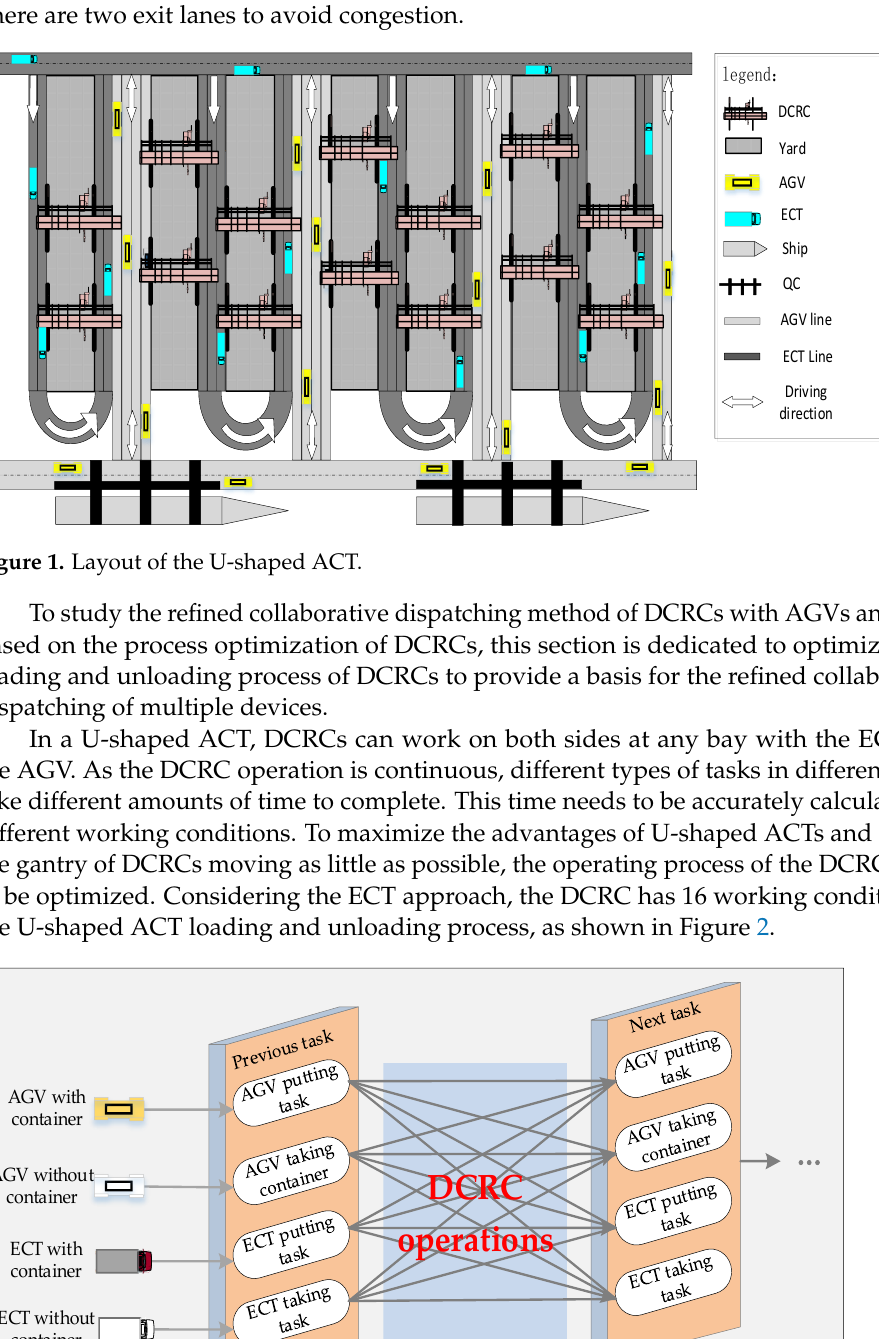
Figure 2. Schematic diagram of the working conditions of the DCRC.